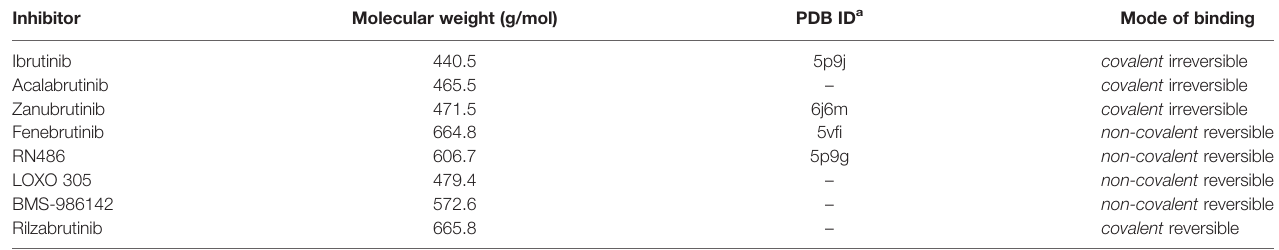
TABLE 1 | Examples of reversible and irreversible BTK inhibitors.